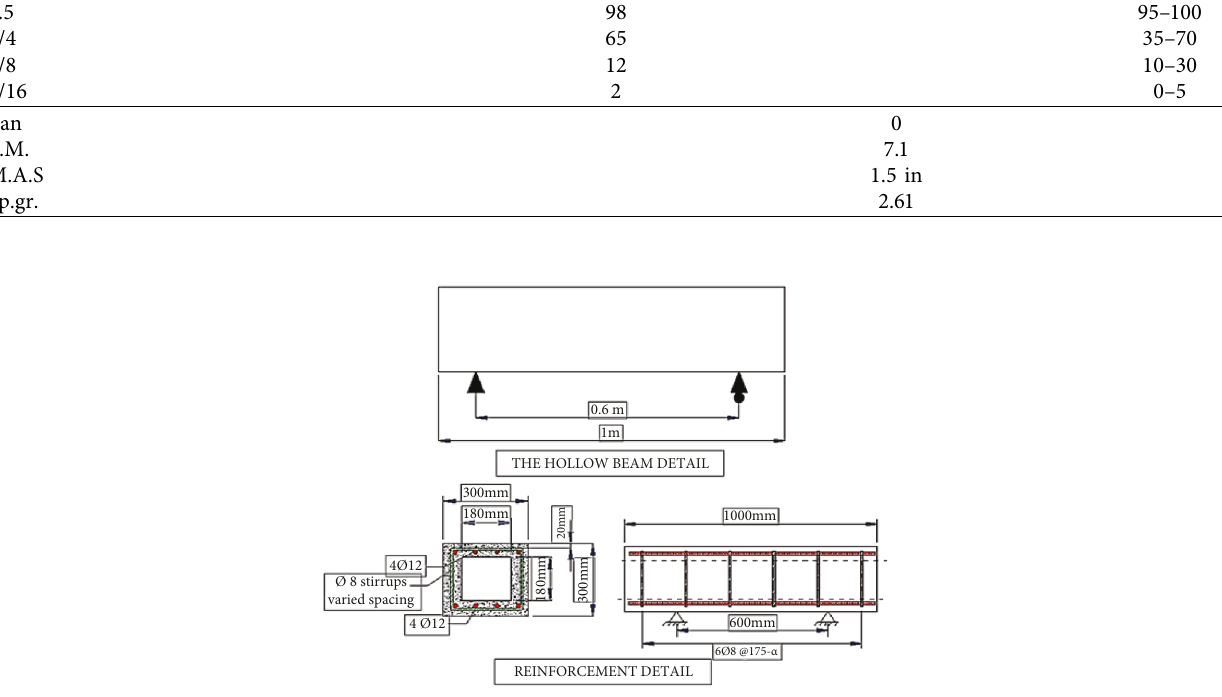
Figure 2: Details of reinforcement of hollow RC beams. Table 5: Specimen group details.